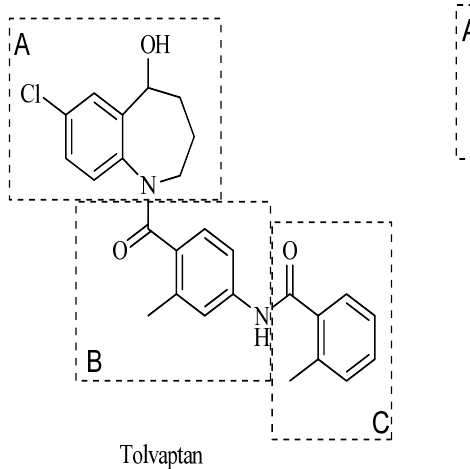
Figure 1. Chemical structures of tolvaptan, lixivaptan and desloratadine ( black : previous study; red : reported here in this